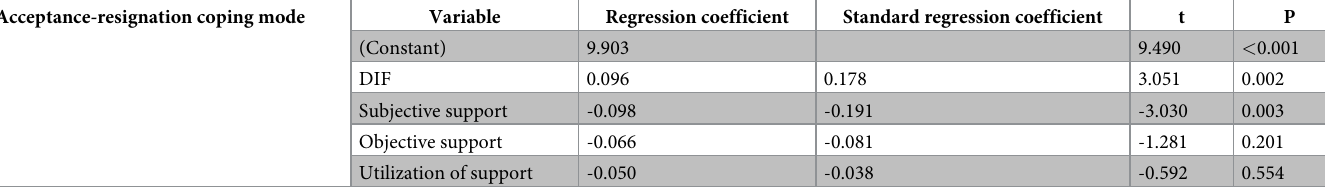
Table 9. Multivariate analysis of the acceptance-resignation coping mode among patients treated with IVF-ET. Acceptance-resignation coping